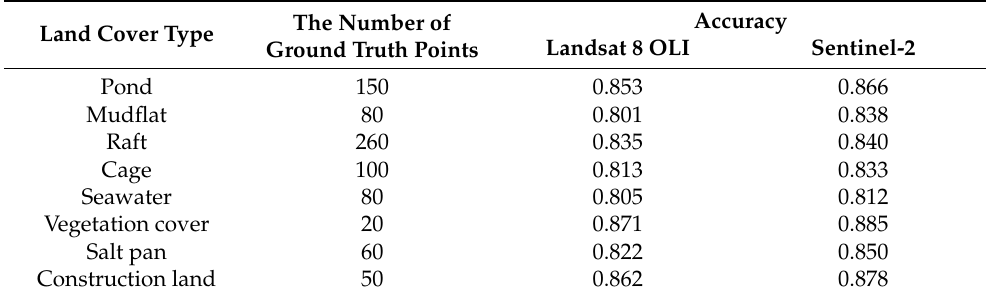
Table A5. Accuracy of field verification of remote sensing image classification results.